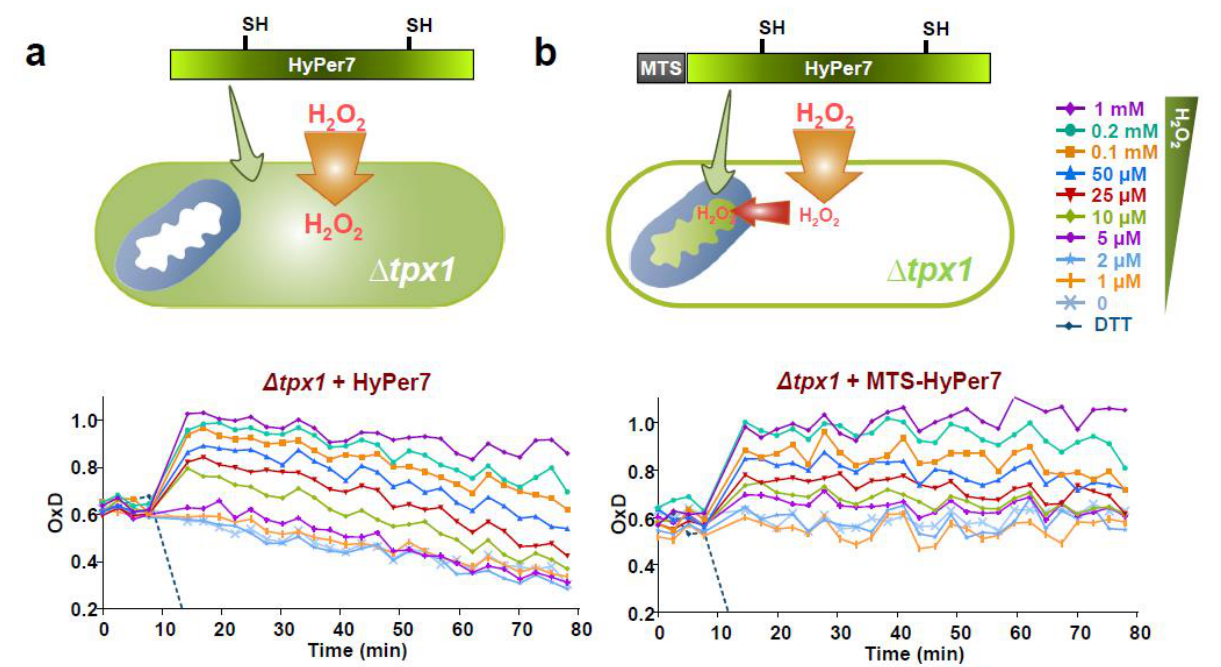
Figure 4. The levels of basal oxidation, OxD 0 , of HyPer7 and MTS-Hyper7 are very similar in cells lacking Tpx1. Strain SG5 (∆ tpx1 ) transformed with p728 ( a ) or p730 ( b ) encoding HyPer7 or MTS-HyPer7, respectively, was grown and analyzed as in Figure 1. Average data from three biological replicates are shown, with error bars (S.D.) displayed in Figure S4.